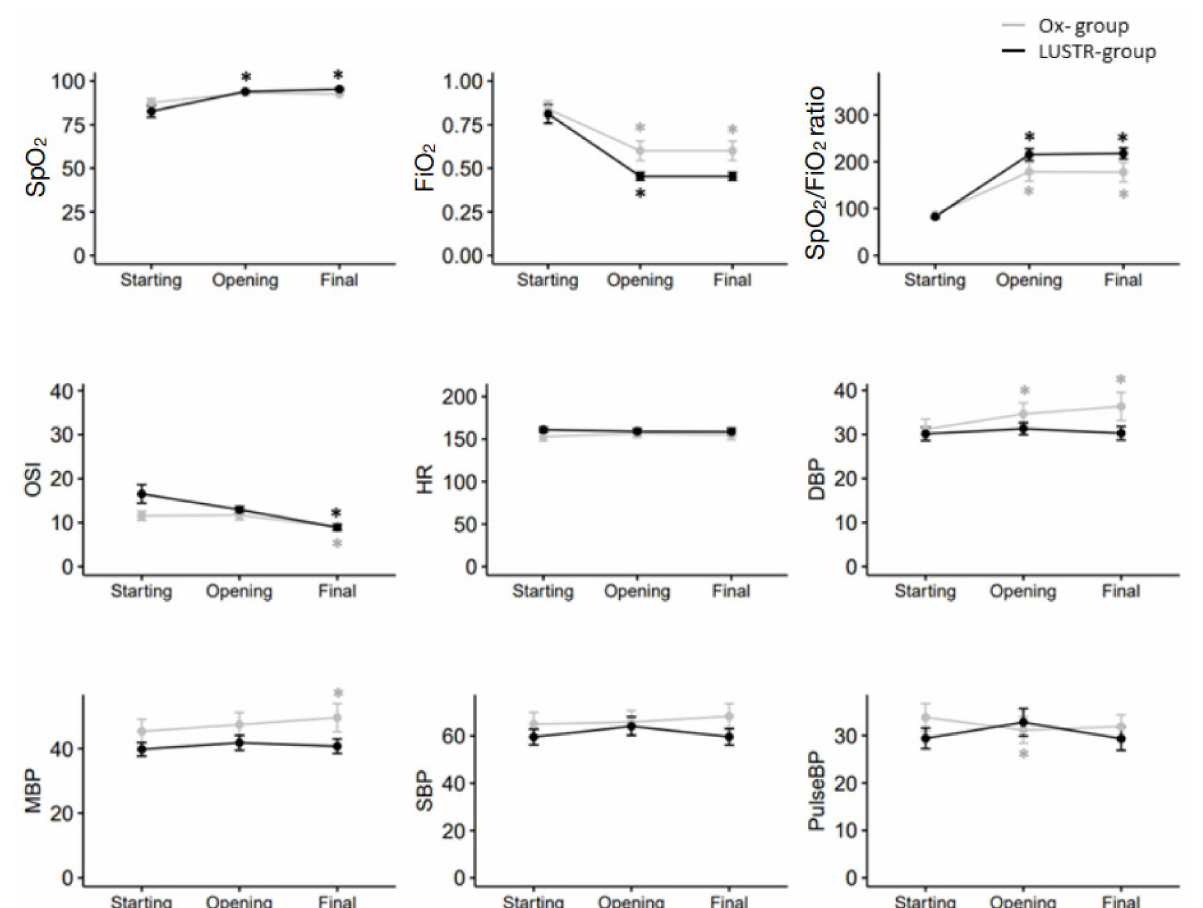
Figure 4. Trends of oxygen parameters and vital signs in the two groups throughout the procedure. The analysis to assess the variation of the different vital signs from the baseline (the starting point of the procedure) was performed by comparing them to the subsequent time points within the groups (opening vs. starting; final vs. starting). * Indicates significant ( p < 0.05) variation from the starting parameter in the specific